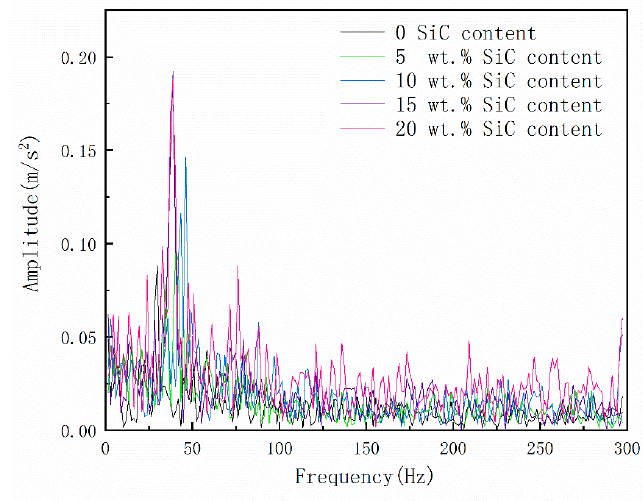
Figure 8. Envelope spectra of material vibration signals. The peaks of the curves in the envelope spectra indicate that the amplitude of the material at this point reaches the maximum value, and the workpiece was in a resonance state at this point. The abscissa value at the peak point was approximately equal to the natural frequency of the material, and the ordinate was the resonance amplitude value of the workpiece at this frequency. The results of the envelope spectra analysis of the vibration signal of the material in the abrasive suspension with different SiC content (0, 2.5 wt.%, 5 wt.%, 7.5 wt.%, 10 wt.%, 12.5 wt.%, 15 wt.%, 17.5 wt.%, and 20 wt.%) and ultrasonic amplitudes (30%, 35%, 40, 45%, 50%, 55%, 60%, 65%, and 70%) are shown in Tables 2 and 3.